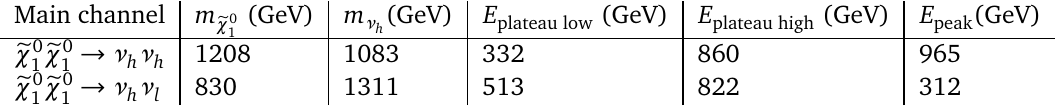
Table 3: The numerical values of the energy of the peak ( E ), the low-energy peak ( E ) and high-energy ( E ) boundary of the plateau of the neutrino plateau low plateau high spectrum for the two show-case files in